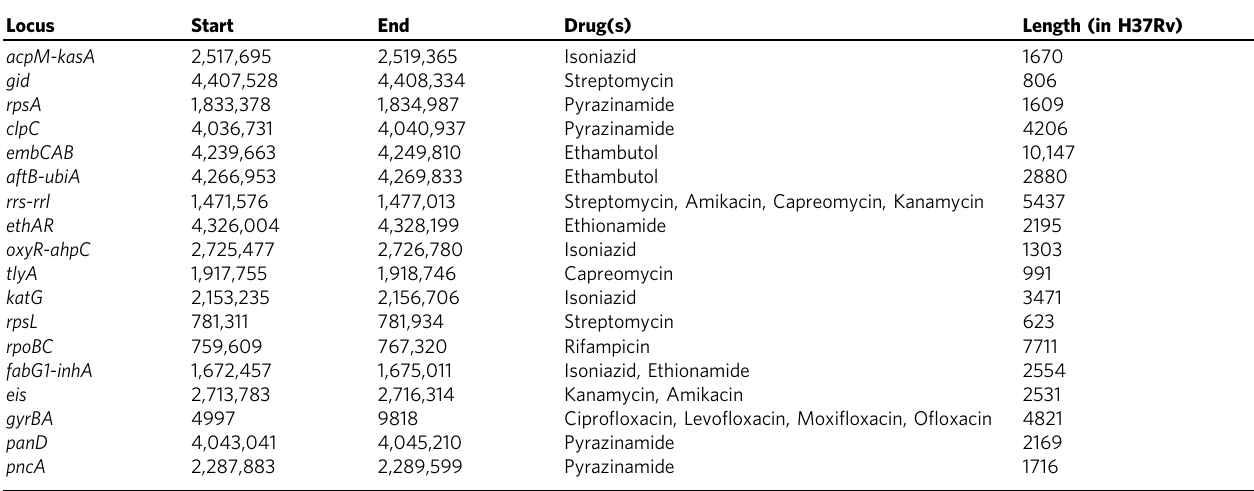
Table 3 Loci included in the MD-CNN and SD-CNN models.